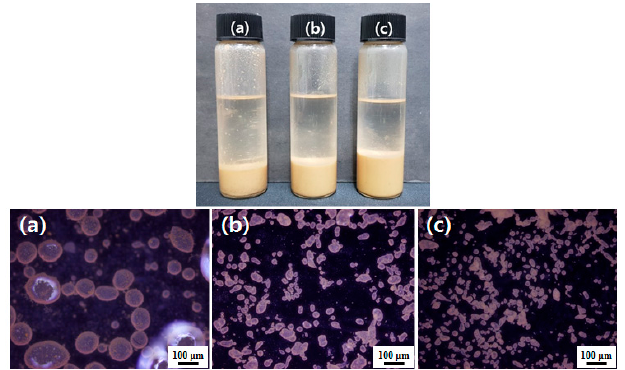
Figure 8. A photograph ( top ) and fluorescence micrographs ( bottom ) of water-in-decalin Pickering emulsions prepared at different PMDA-ODA particle concentrations: ( a ) 0.5 wt %, ( b ) 1.0 wt %, and ( c ) 1.5 wt %. The volume ratio of oil-water was 6:1. Fluorescence micrographs are provided for more clarity (excitation wavelength = 330~380